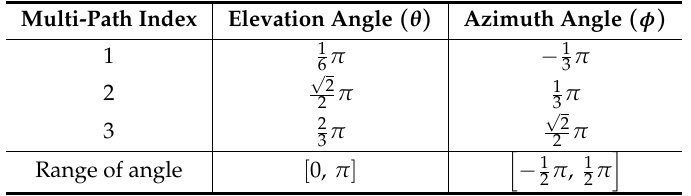
Table 1. Example of the azimuth and elevation angles for the